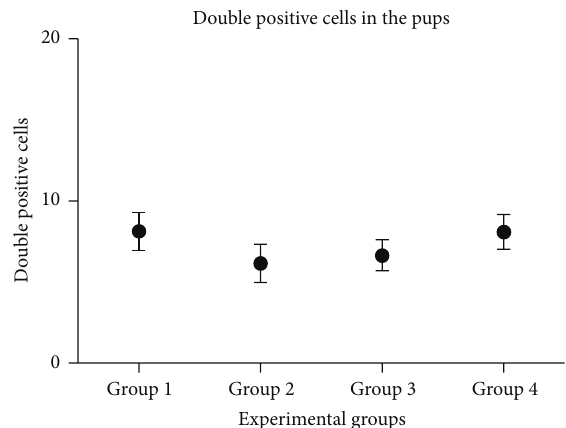
Figure 10: Double positive lymphocyte population. The experimen- talgroupsaredisplayedinthe 𝑥 -axisitshowed,andinthe 𝑦 -axis,the average percentage of double positive cells is